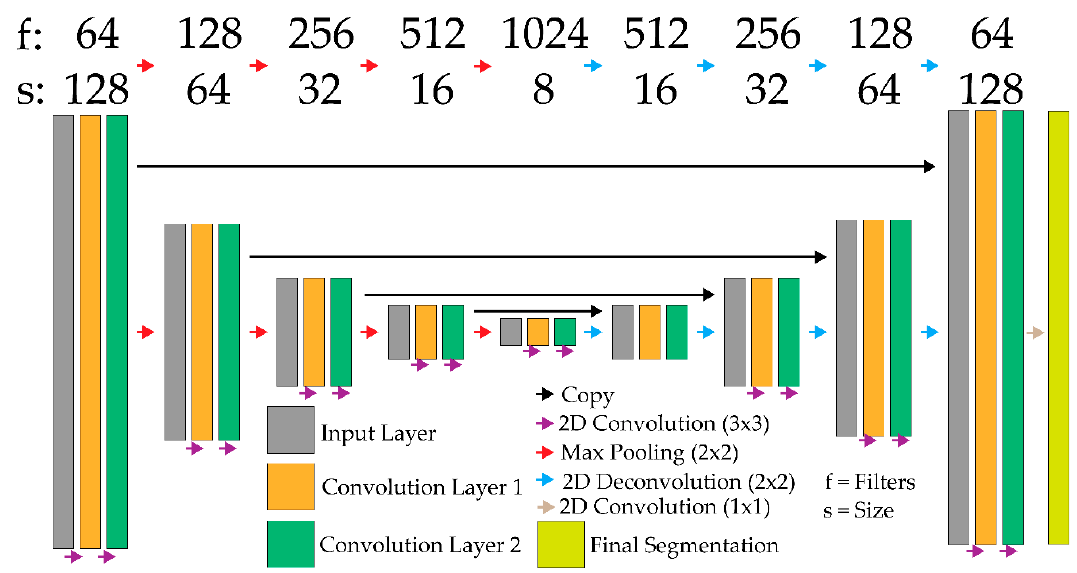
Figure 2. Conceptualization of UNet semantic segmentation architecture.